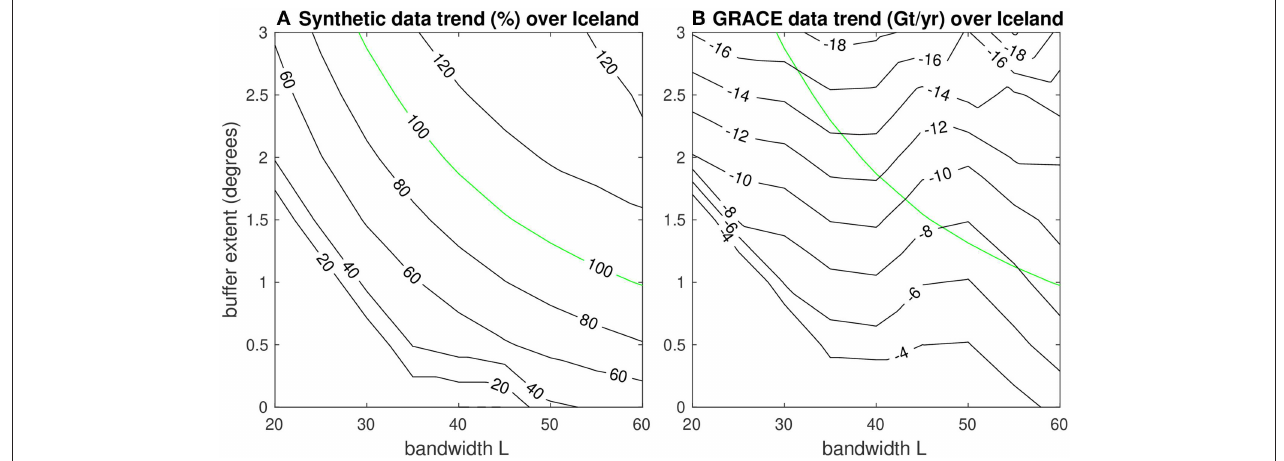
FIGURE 2 | (A) Synthetic trend recovery over Iceland. The contours represent the percent signal recovered from the synthetic data for each choice of buffer and bandwidth. (B) Real trend recovery over Iceland. The contours represent the actual trend estimates calculated from GRACE data for each choice of buffer and bandwidth. The 100% recovery contour from (A) is shown in green. For the bandwidth of the data ( L = 60), the 100% recovery contour closely aligns with the choice of a 1.0 ◦ buffer around Iceland.